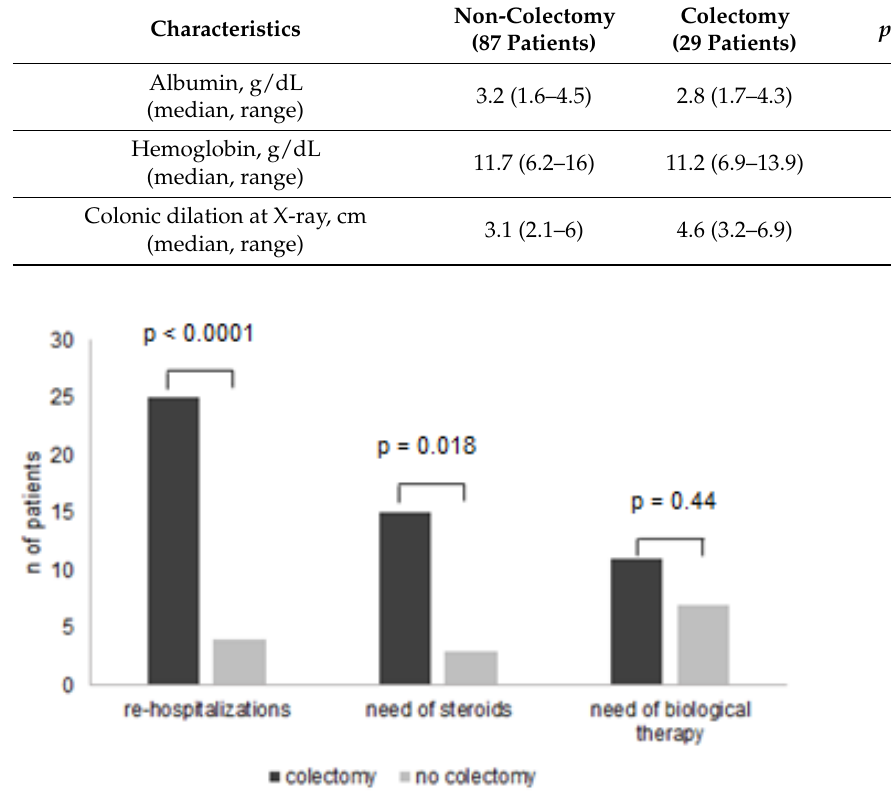
Figure 1. Comparison between colectomy and non-colectomy groups according to the need for re-hospitalization, steroids, and biological therapy during follow-up. Table 1. Comparison of clinical parameters and laboratory and radiological data between the non- colectomy and colectomy groups.